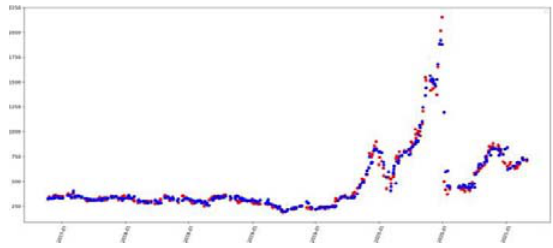
Figure 16: Share Price vs Date